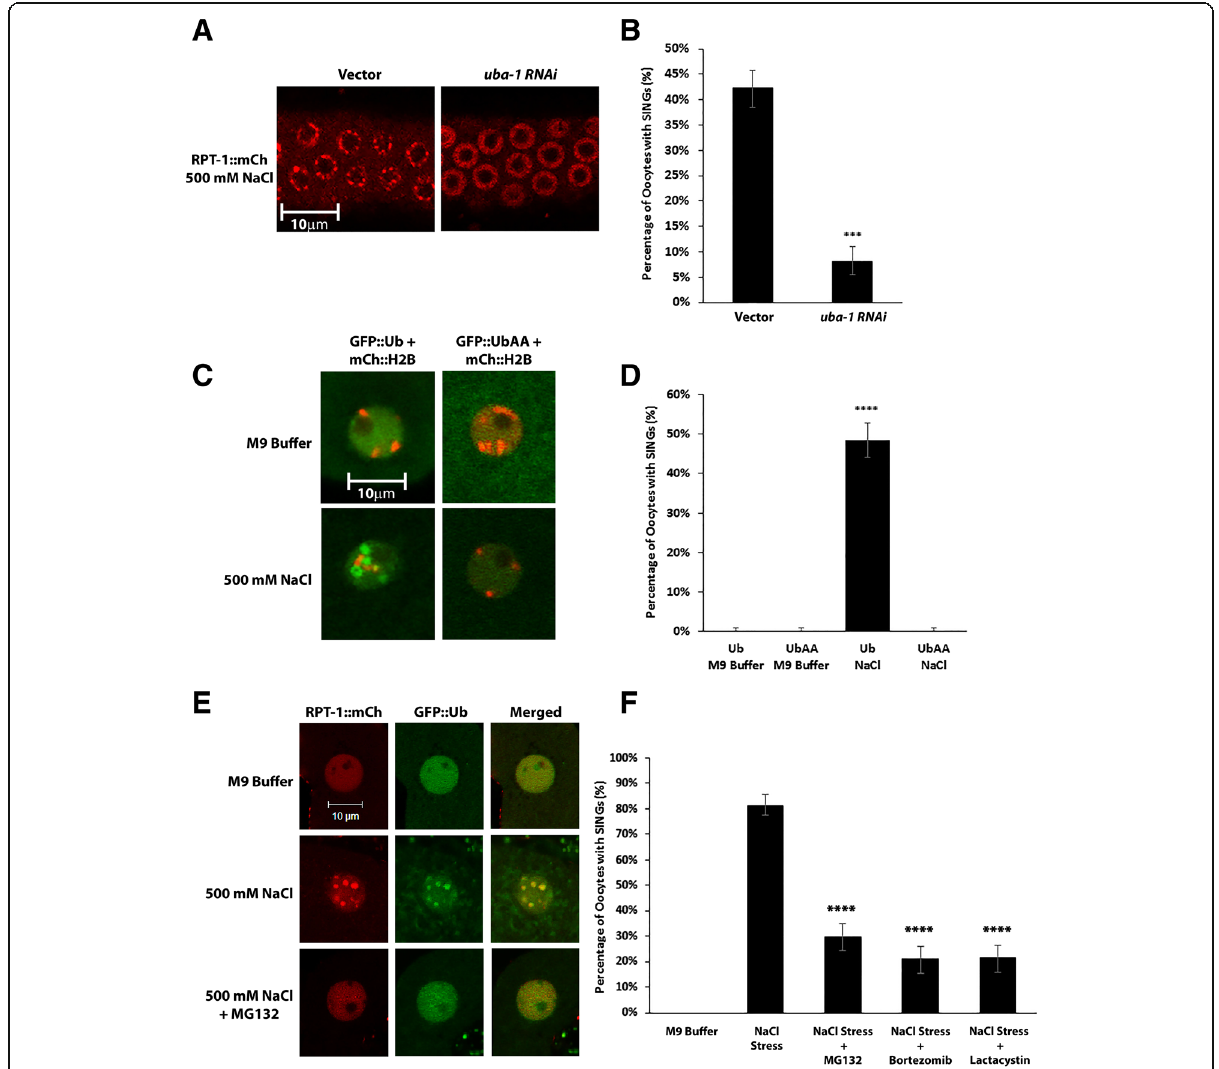
Fig. 4 SING formation requires ubiquitination and proteasome activity. a Worms expressing RPT-1::mCh were subjected to uba-1 RNAi for 24 h prior to soaking in 500 mM NaCl for 60 min. RPT-1::mCh does not localize to SINGs when uba-1 is knocked down. Scale bar indicates 10 μ m. b The percentage of oocytes forming SINGs after uba- 1 RNAi treatment as described in A. A total of 1020 oocytes were analyzed from 3 independent experiments ( n = 30 worms). Statistical significance was calculated by a two-tailed z test: *** p < 0.001. c Unconjugated ubiquitin does not localize to SINGs. A worm strain expressing GFP::Ub ( green ) and mCh::H2B ( red ) shows localization of GFP::Ub to SINGs after soaking